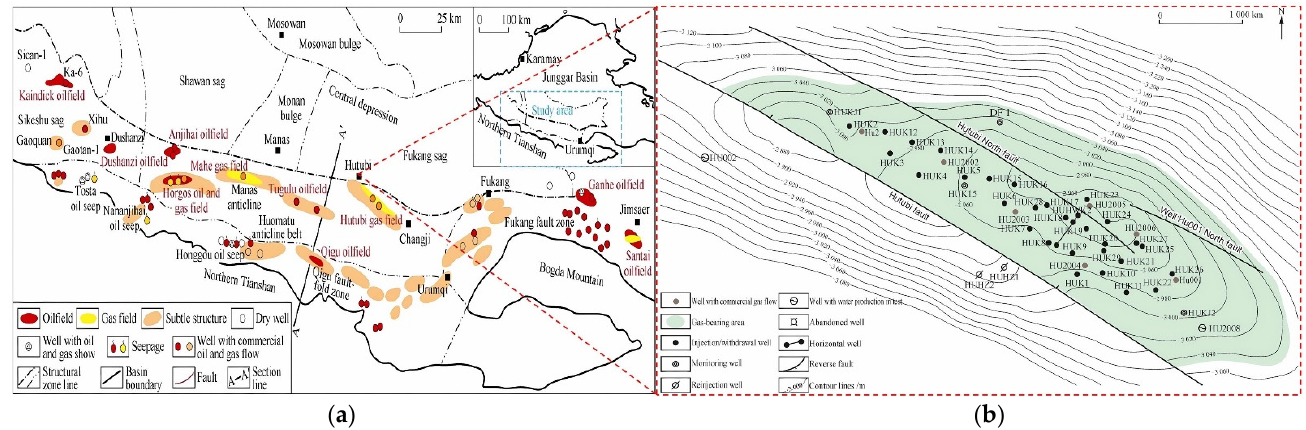
Figure 8. ( a ) Regional location of the Hutubi UGS (modified from Chen et al. [65]); ( b ) Well location distribution of the Hutubi UGS (modified from Zheng et al. [66]).